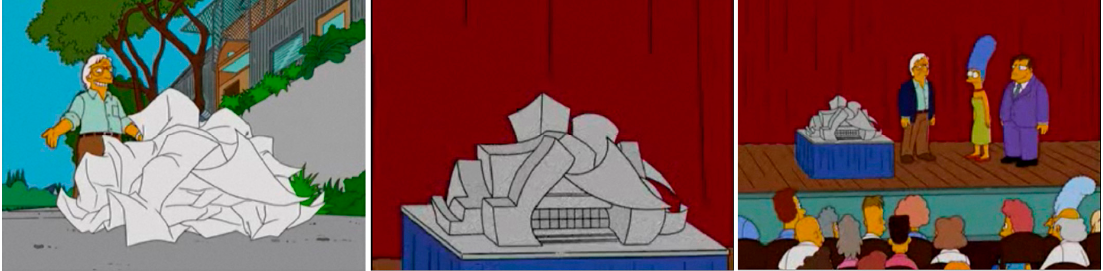
Figure 1. Scenes from the 14th episode of the 16th series of “The